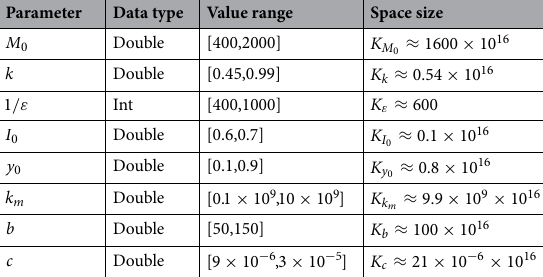
Table 2. List of parameter types and range of the proposed MTCNN.